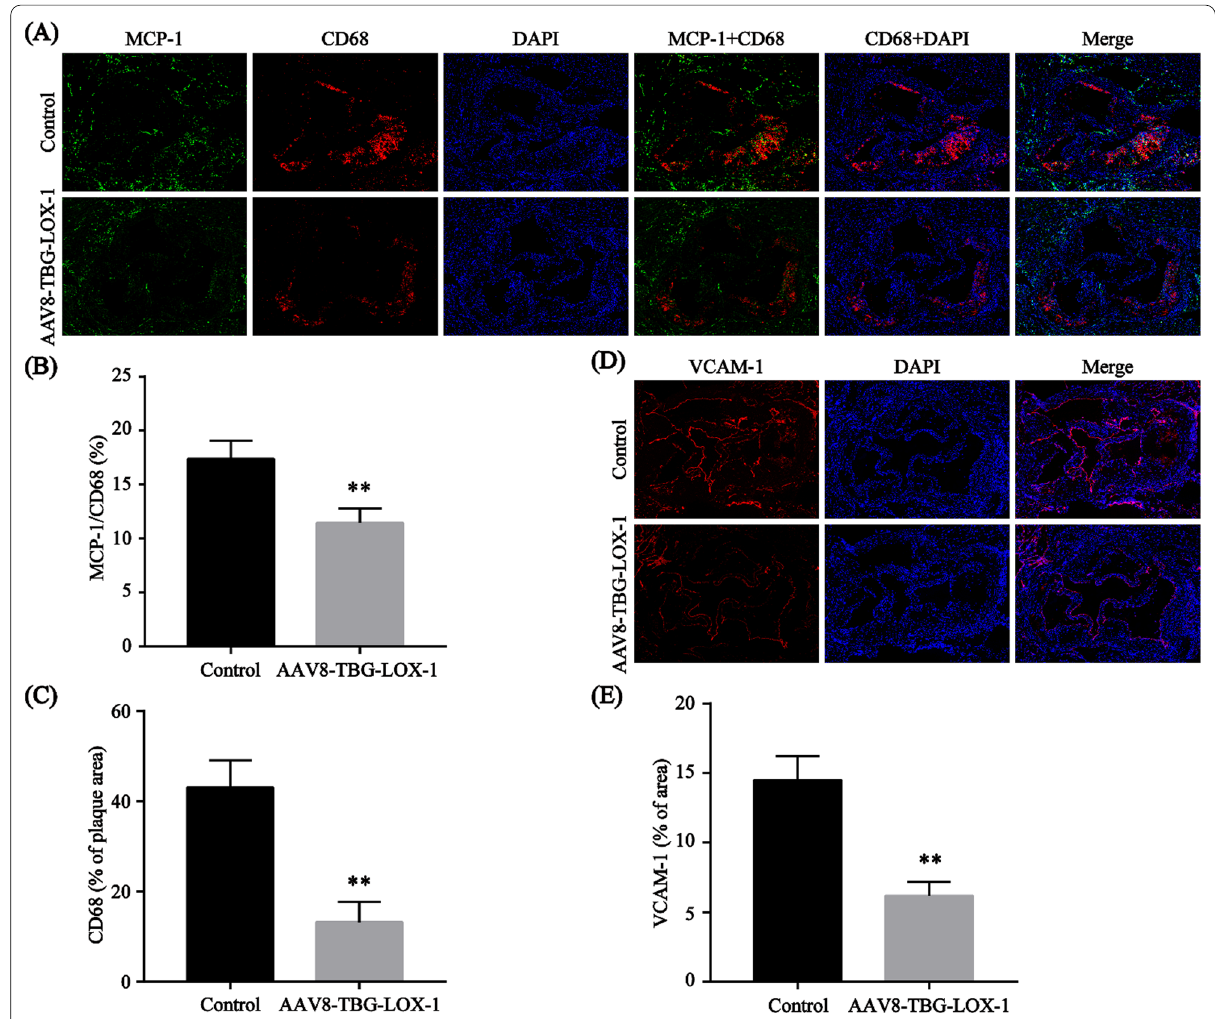
Fig. 6 Clearance of circulating Ox-LDL by ectopic expression of LOX-1 in the liver significantly reduce migration of macrophages in plaques and VCAM-1 expression in vascular endothelium. A – C Representative images of the co-localization of MCP-1 and CD68 in the plaque obtained from the control and LOX-1 groups by using immunofluorescence ( A ). DAPI were used to stain nuclei (blue). The percentage of MCP-1/CD68 is presented among the indicated groups ( B ). The percentage of the plaque area that was occupied by CD68 is presented among the indicated groups ( C ). D , E Representative images of the plaque in the control and LOX-1 groups stained with VCAM-1 ( D ). DAPI were used to stain nuclei (blue). The percentage of the aortic root area that was occupied by VCAM-1 is presented among the indicated groups ( E ). Values are expressed as mean (n 7). **P < 0.01 compared with the control =